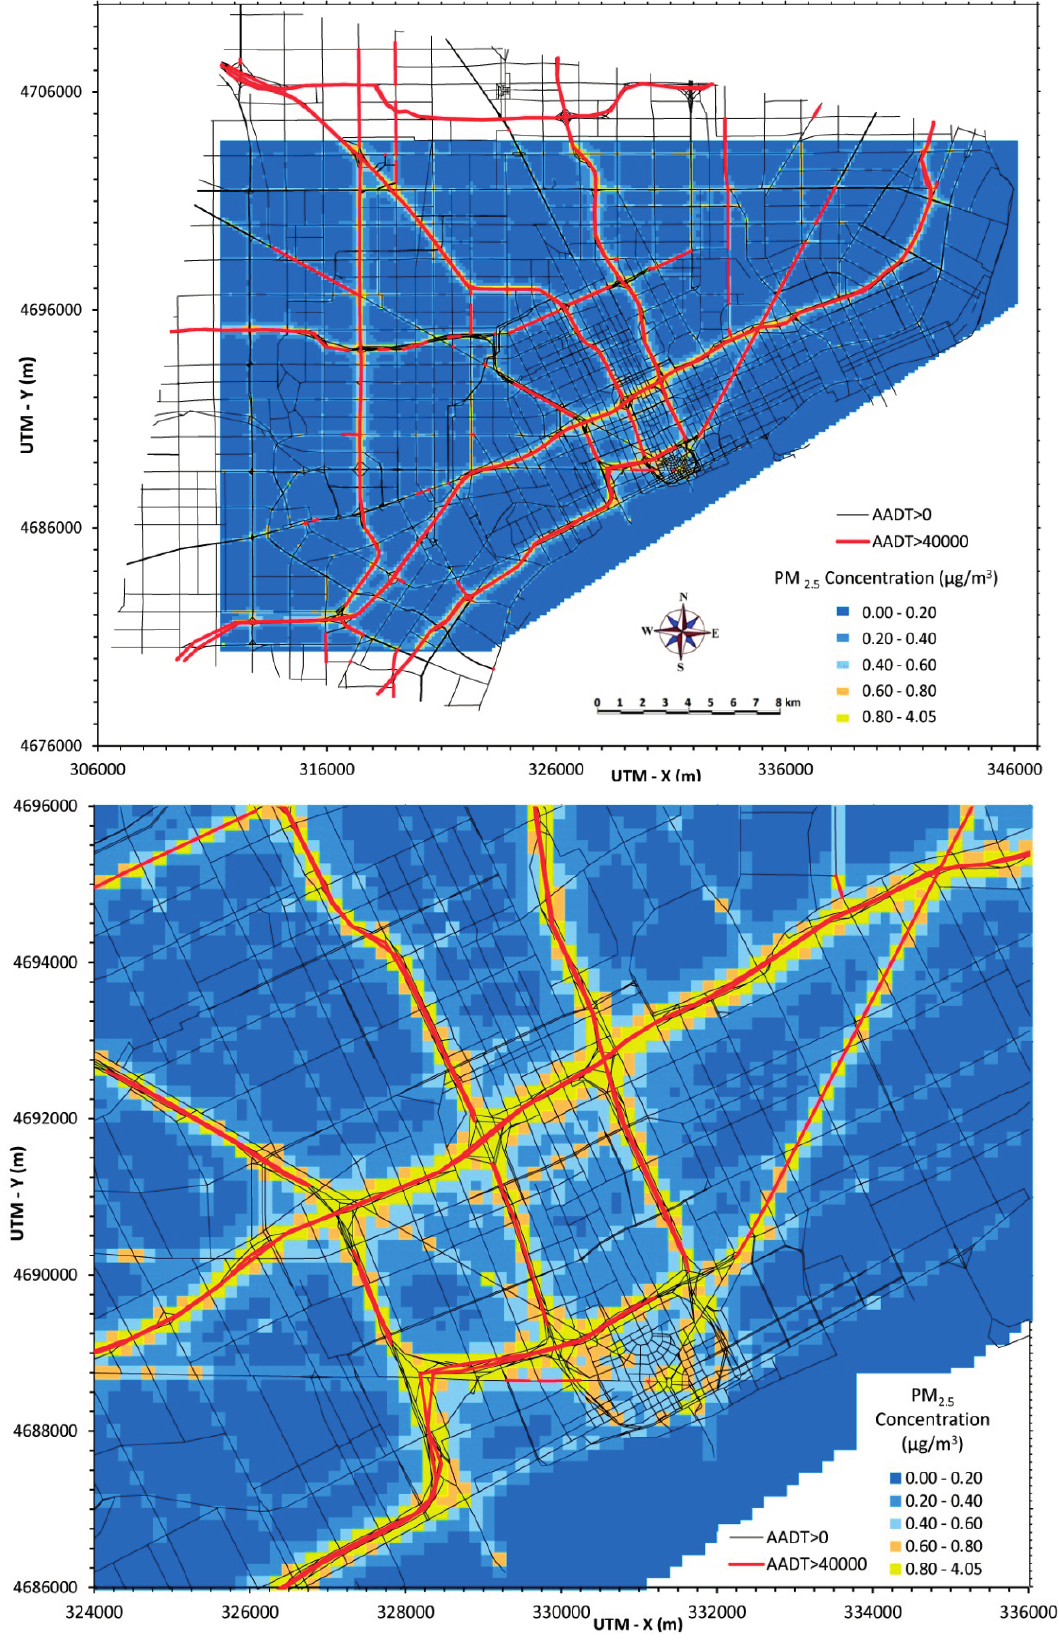
Figure 1. Annual average PM 2.5 concentrations from traffic emissions across Detroit (40 × 30 km area, top) and in central area (10 × 12 km area,